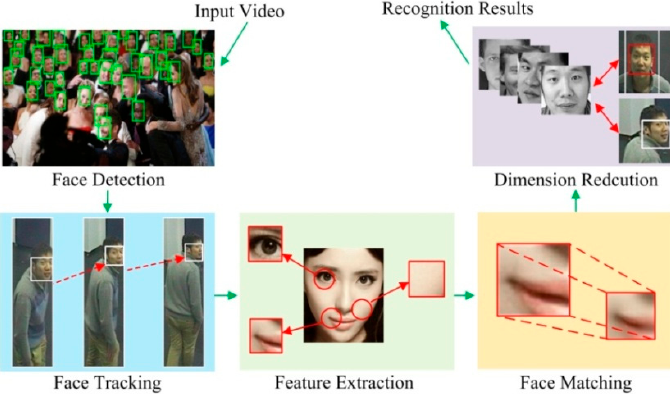
Figure 3. Key steps of the video-based face recognition scheme.